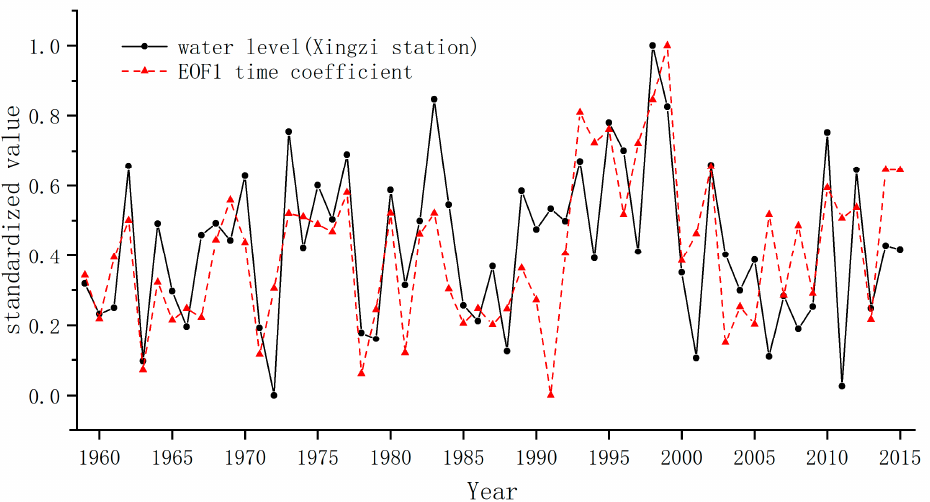
Figure 8. The black solid line indicates the trend of the standardized value of water level in the PYLB during 1959–2015. The red dashed line represents the trend of standardized value of EOF1 time coefficient during 1959–2015.